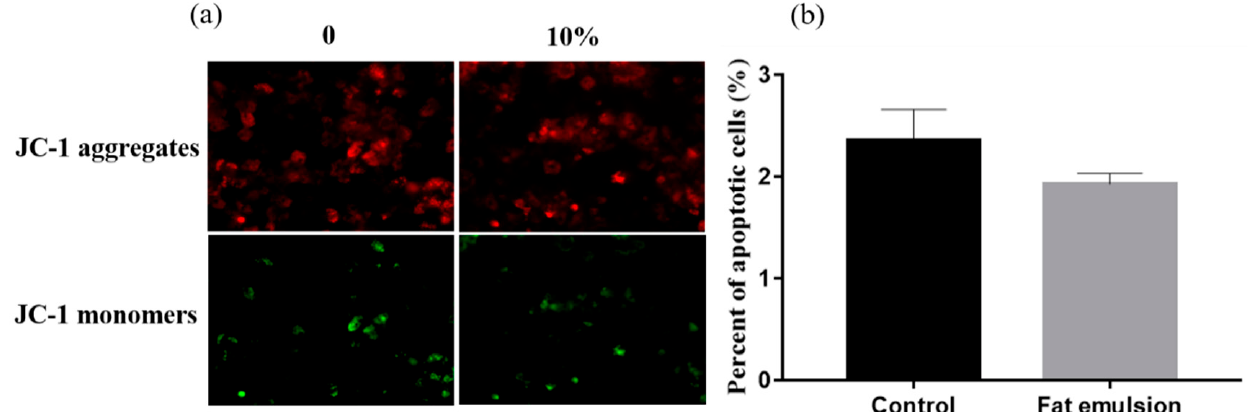
Figure 2. Effect of fat emulsion on mitochondrial membrane potential and apoptosis of hepatocytes. ( a ) Representative images of JC-1 staining in different groups (200 × ). Red fluorescence represents the mitochondrial aggregated form of JC-1, indicating normal membrane potential from intact mitochondria. Green fluorescence represents the monomeric form of JC-1, indicating loss of membrane potential ( ∆Ψ m). ( b ) The ratio of green to red reflects the percentage of cells in apoptosis. Note: Data are presented as mean ± SEM; statistical differences were assessed by one-way ANOVA with subsequent Tukey’s HSD test (the same below).